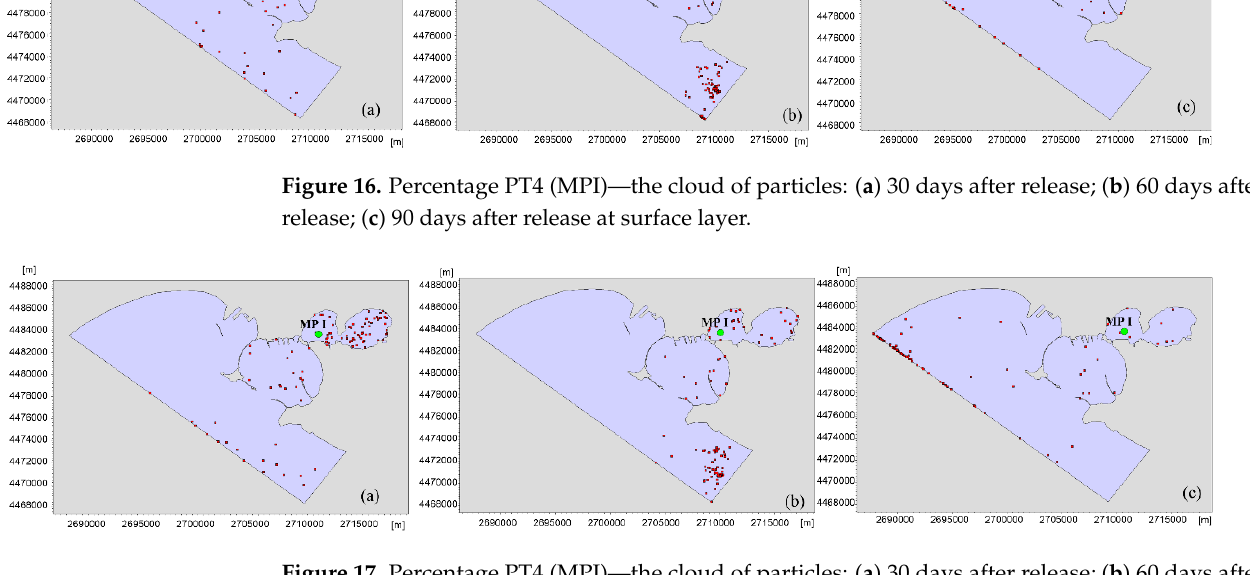
Figure 16. Percentage PT4 (MPI) — the cloud of particles: ( a ) 30 days after release; ( b ) 60 days after release; ( c ) 90 days after release at surface layer.